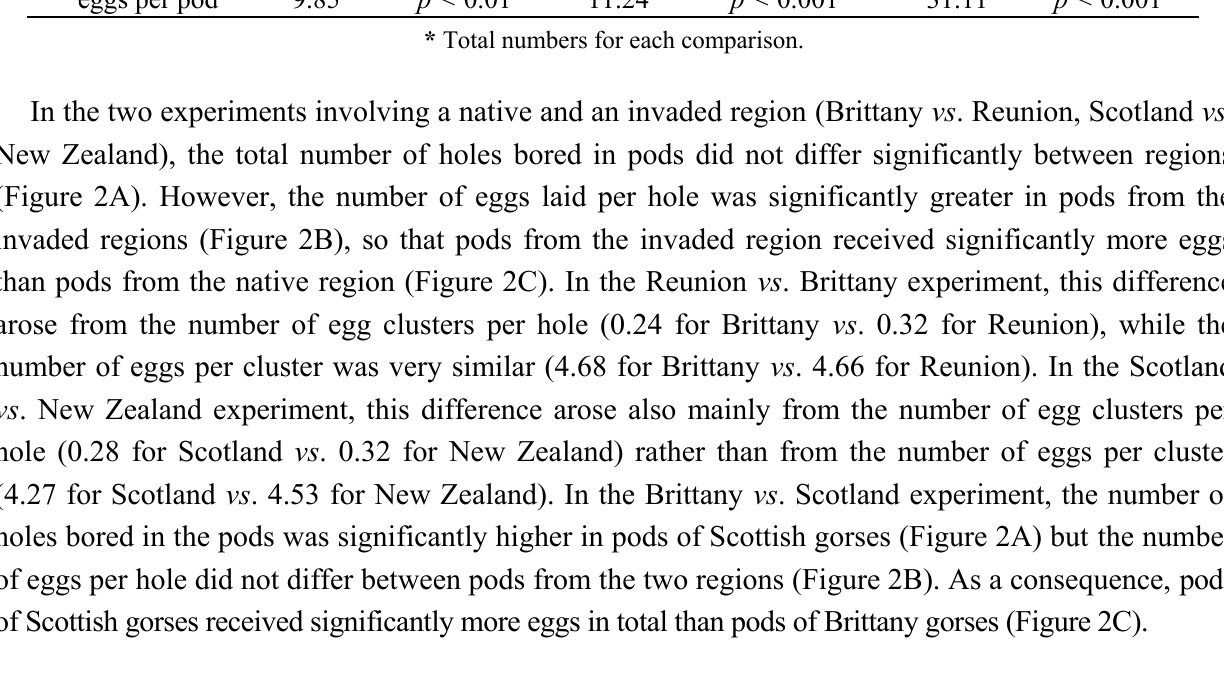
* Total numbers for each